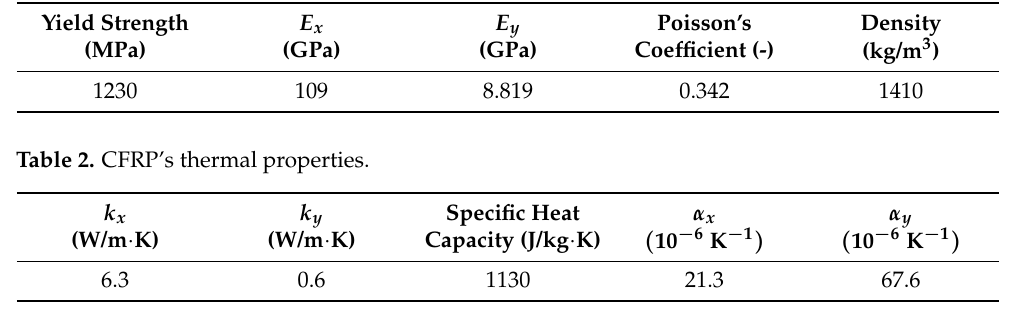
Table 1. CFRP’s mechanical properties.